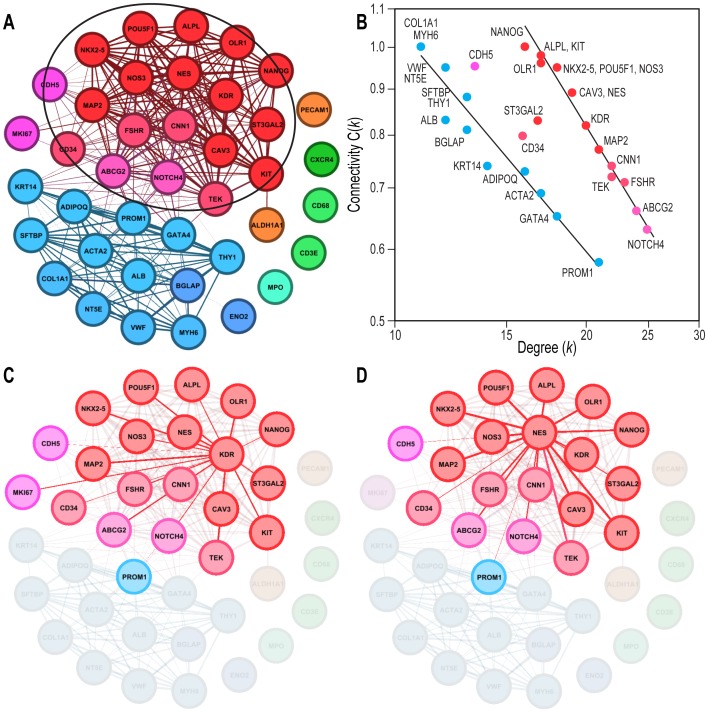
Modular organization of a PBMC gene sub-network.
A. Network representation of the genetic covariation. The thickness of each connecting line is proportional to the absolute value of the respective Pearson's correlation coefficient. Genes that were significantly correlated with the age, AIx, AoPP and BMI of the subjects are encircled (cf. Table 3). Color coding identifies the participation of genes in separate underlying clusters [30]. B. Scaling of nodes' clustering coefficient C(k) with their connectivity degrees k, as a signature of hierarchical networks. Note that the data spontaneously split into two subpopulations, suggesting distinctly organized modules (for clarity, the leukocyte genes were omitted). Members of Module 1 (right), corresponding to the functionally filtered group in A (same color convention), had higher clustering values for similar k values than those in Module 2 (left), indicating stronger transcriptional coupling. C. Genes connected to the KDR node. Note that these connections perfectly overlap those of Module 1, while PROM1/CD133 serves as a link with Module 2, arguing that KDR is a hub node of Module 1. D. Connections of another hub node, NES. The images in A, C and D are based on Pearson correlation coefficients r>|0.8| and were obtained using the software Gephi 0.8 beta (www.gephi.org). The data shown in B were also obtained using Gephi, based on the network analysis in A.